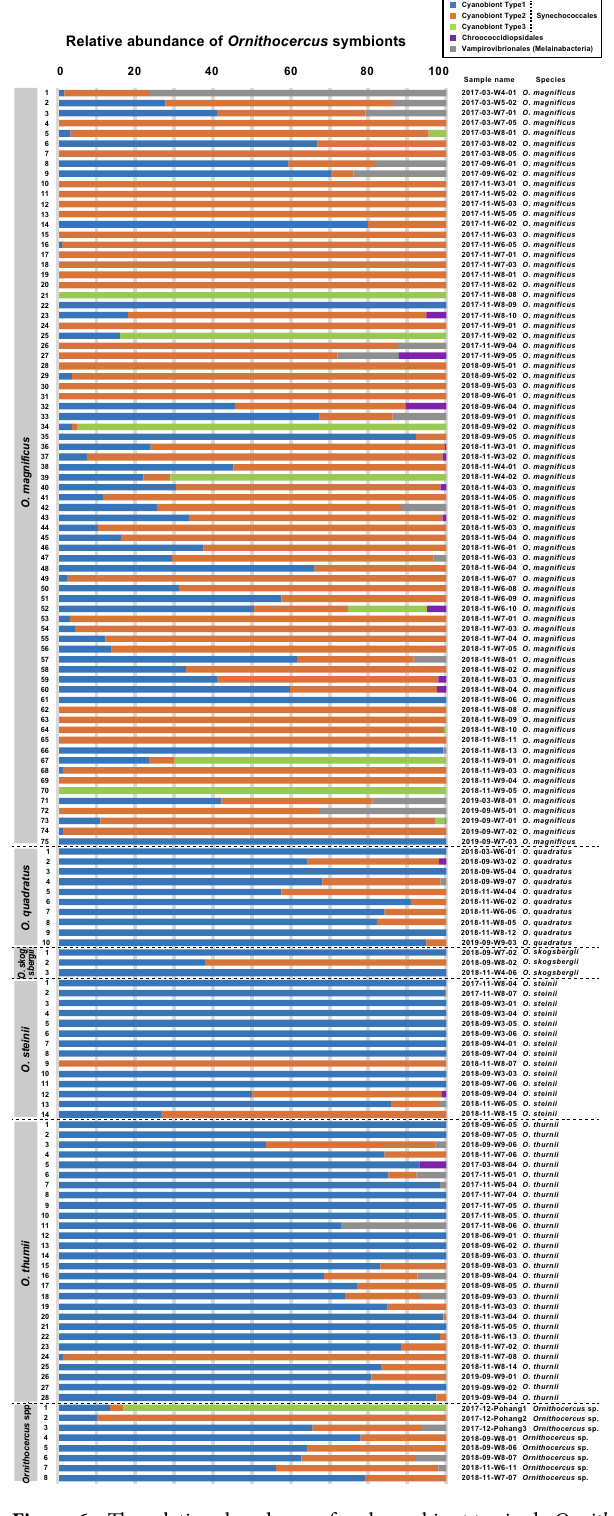
Figure 6. The relative abundance of each symbiont to single Ornithocercus cells. Note that it is listed by host